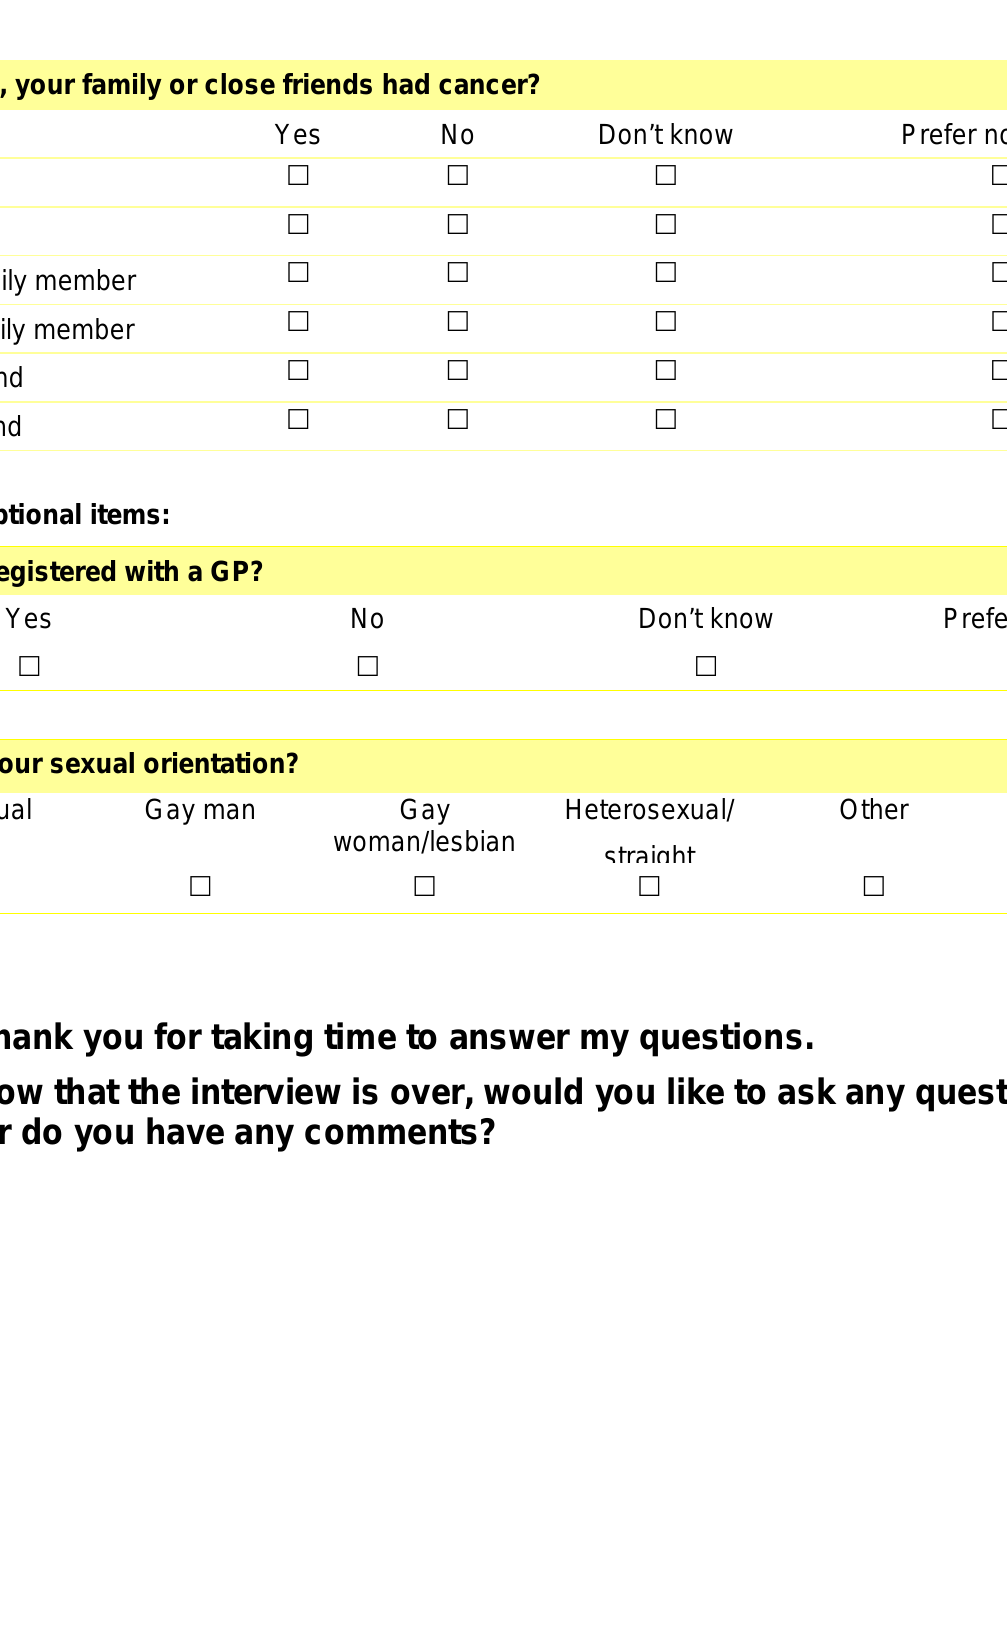
Cervical Cancer Awareness Measure Toolkit Version 2.1 Updated